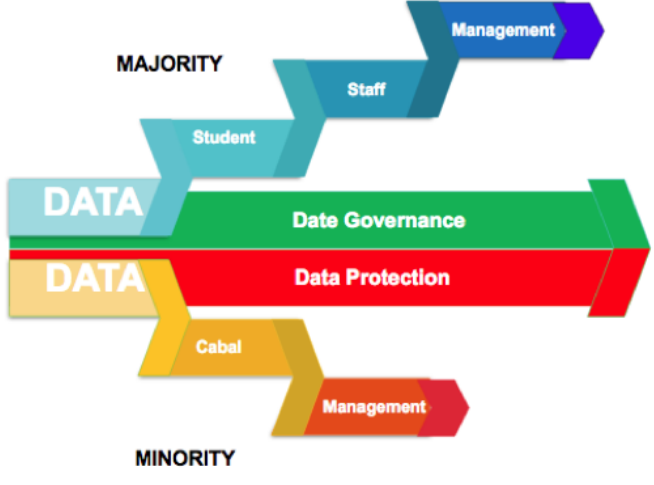
Figure 2. Effect of data protection vs. data